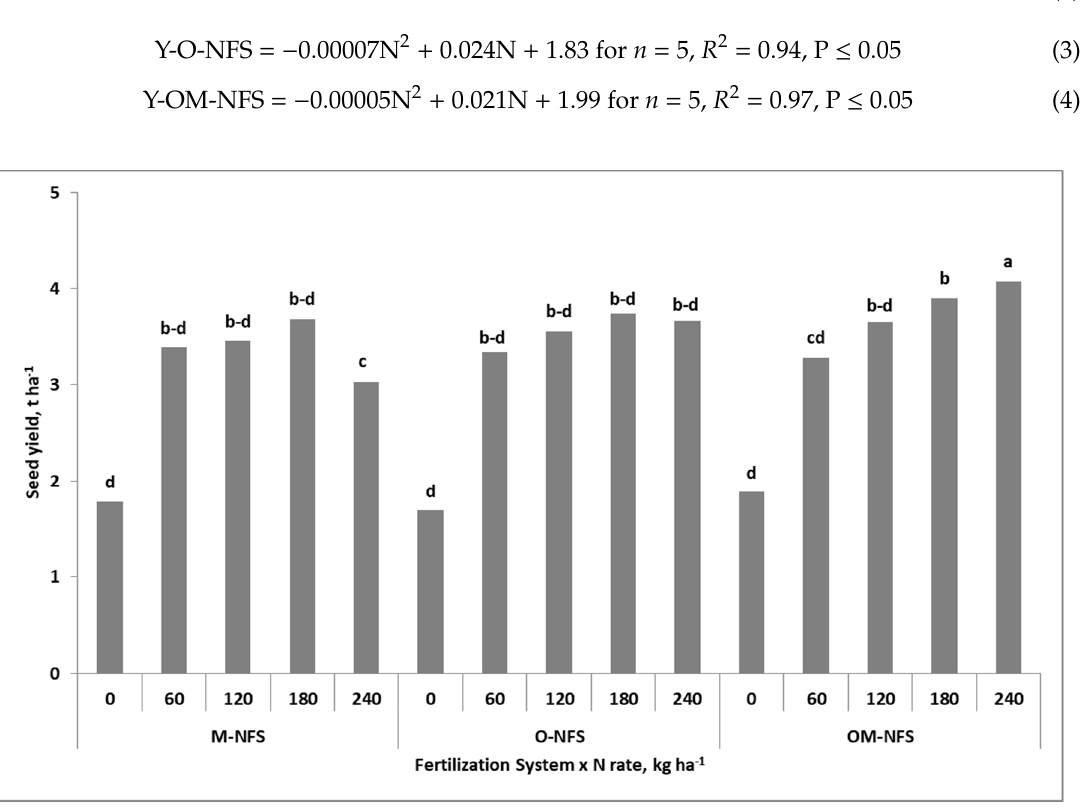
Figure 1. Yield of winter oilseed rape as affected by N rates on the background of nitrogen fertilization systems (NFSs). M-NFS, O-NFS, OM-NFS—mineral, organic, organic-mineral, respectively. a, b, c, d significance letters, a—the highest, d—the lowest; a means within a column followed by the same letter indicate a lack of significant difference between the treatments.